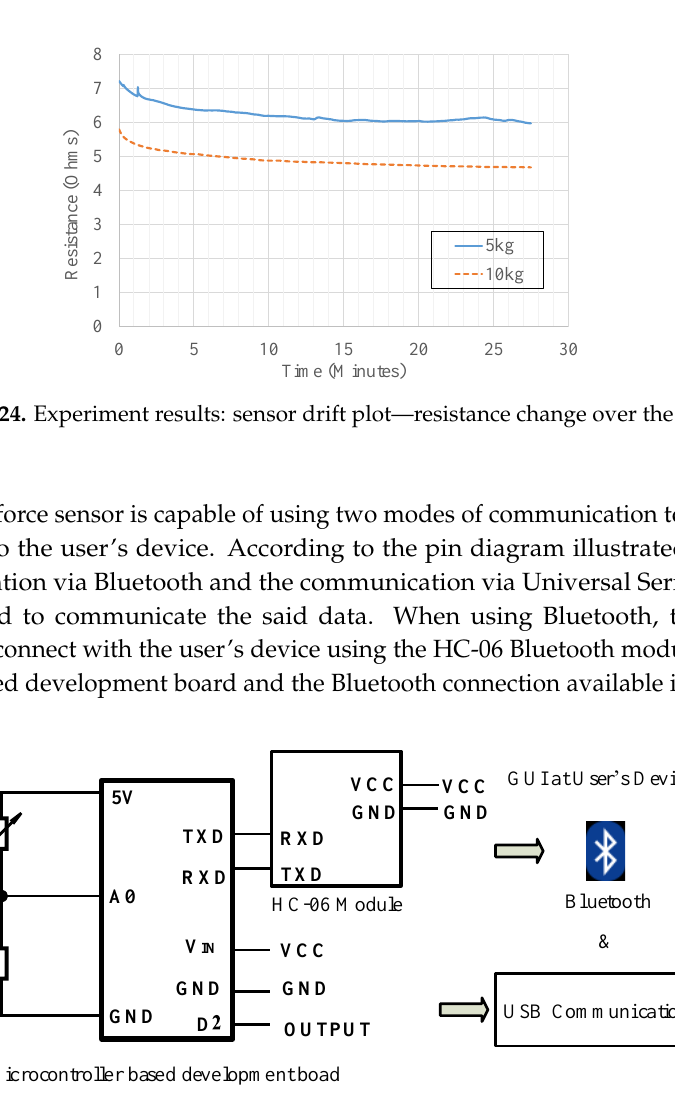
Figure 25. Circuitry for the developed communication